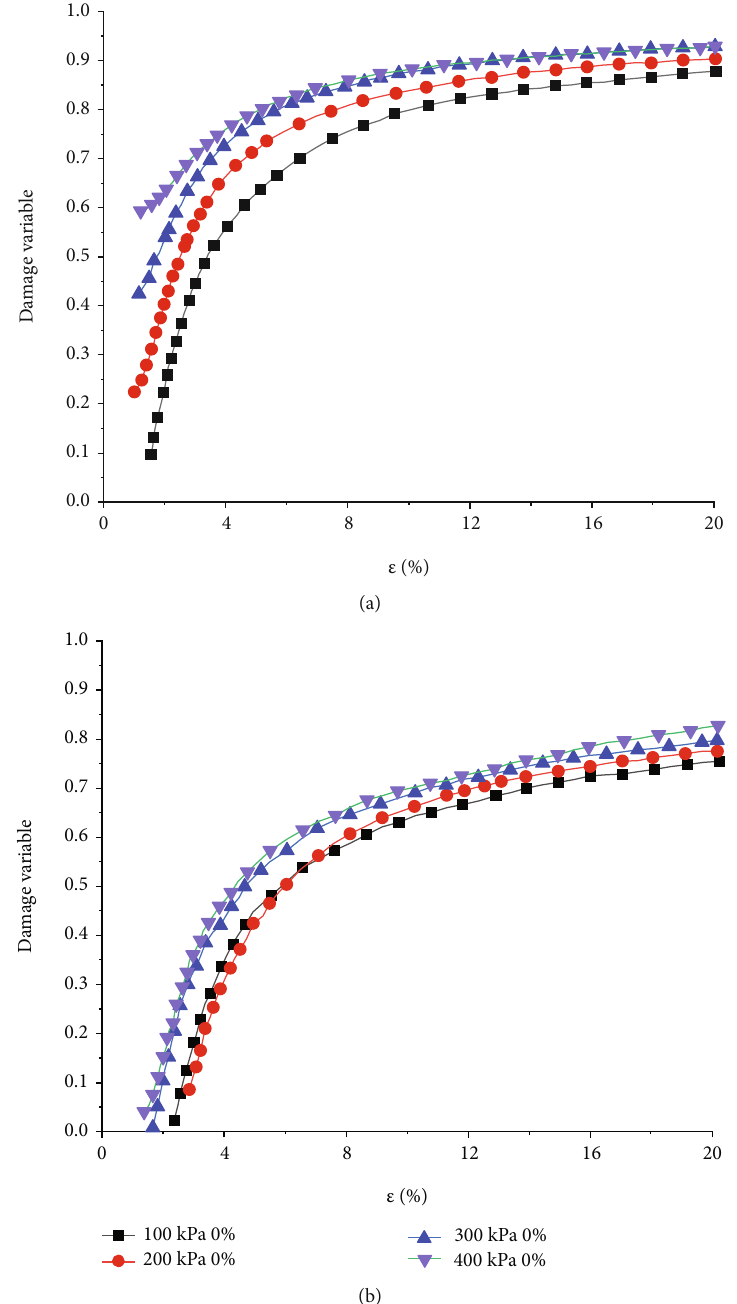
Figure 9: Comparison curves of damage variables under di ff erent con fi ning pressures. (a) The initial dry density is 1.45g/cm 3 . Concentration of Cr 3+ 0%. (b) The initial dry density is 1.45 g/cm 3 . Concentration of Cr 3+